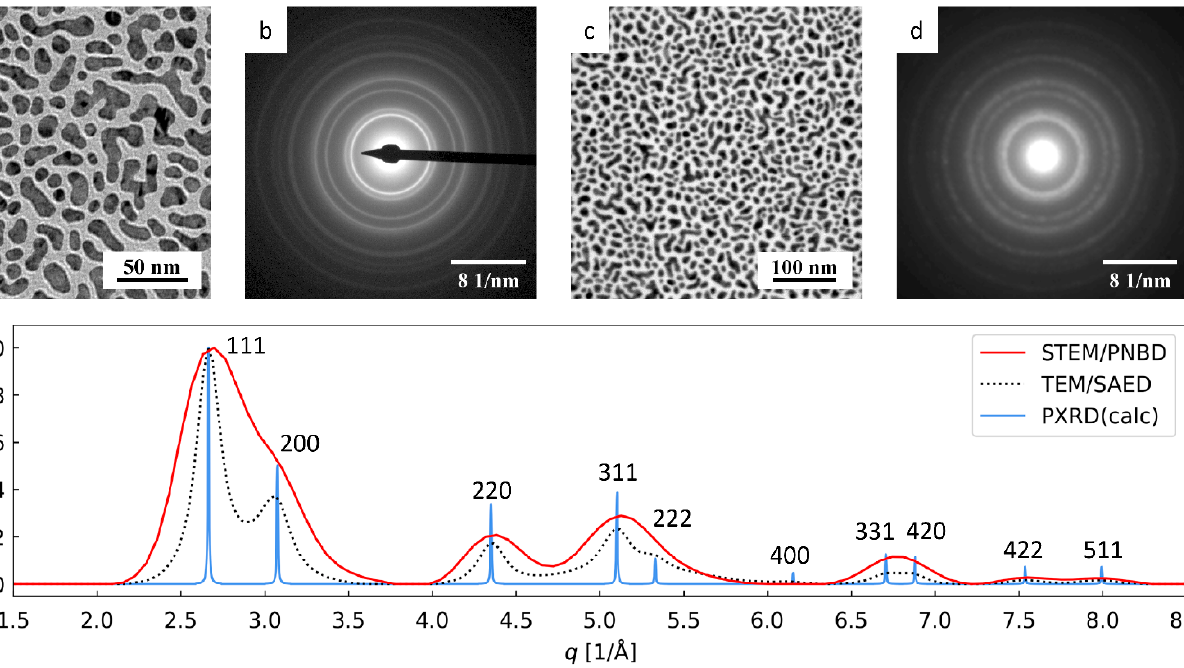
Figure 3. 4D-STEM/PNBD results for Au nano-islands and their comparison with TEM and PXRD (powder X-ray diffraction) results: ( a ) TEM/BF image, ( b ) TEM/SAED diffraction pattern, ( c ) STEM/BF image, ( d ) 4D-STEM/PNBD diffraction pattern, and ( e ) comparison of radially averaged results from 4D-STEM/PNBD (red line), TEM/SAED (black dotted line), and theoretically calculated PXRD diffraction pattern of Au.